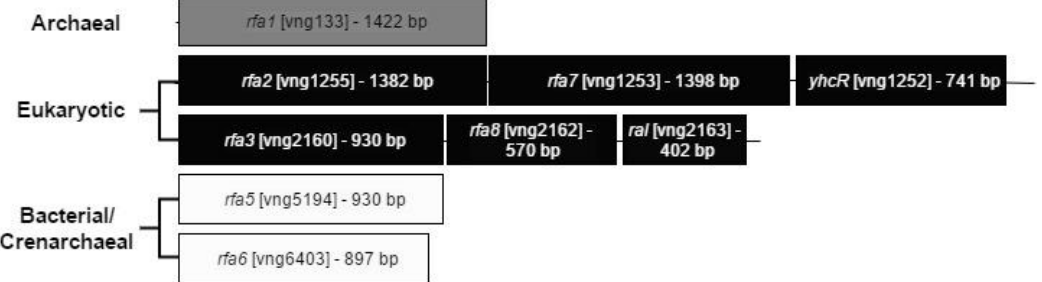
Figure 1. Operon structure and relatedness of the RPA homologues in Hbt. salinarum. The Archaeal homolog Rfa1 contains three OB-folds, and is unique to the euryarchaeal lineage [8] The two eukaryotic homologs are each found in three-gene operons, with the first and second genes showing homology to eukaryotic RPA1 and RPA2, respectively. The three genes of the rfa3 operon ( rfa3 , rfa8 , and ral ) have been shown to be co-transcribed [14]. Similar evidence for the rfa2 operon is presented